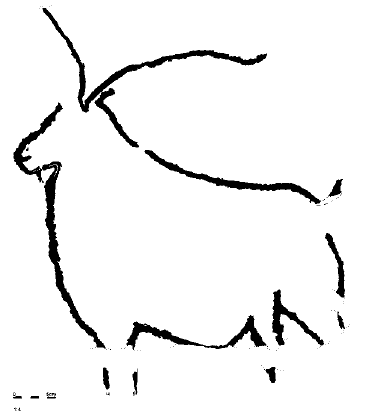
Figure 3. Canada do Inferno Rock 1, Côa Valley, Portugal. Aurochs depiction. See also engraving phase 5 in Figure 14. Tracing: Fernando Barbosa, assisted by João Félix and Teresa Fonseca.